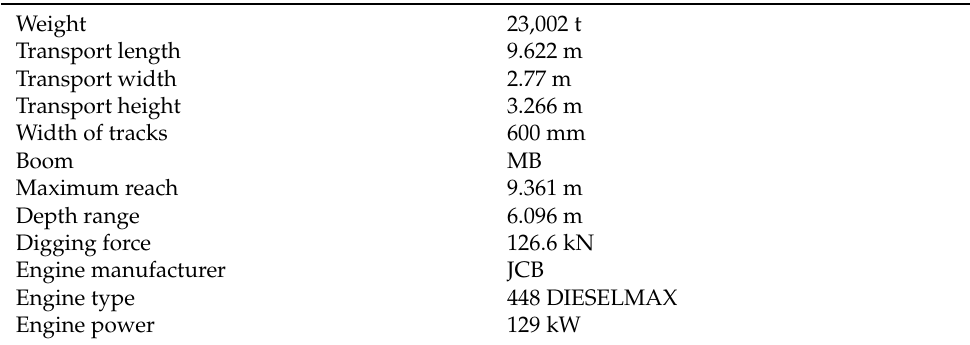
Table 1. Technical parameters of JCB JS 220 LC